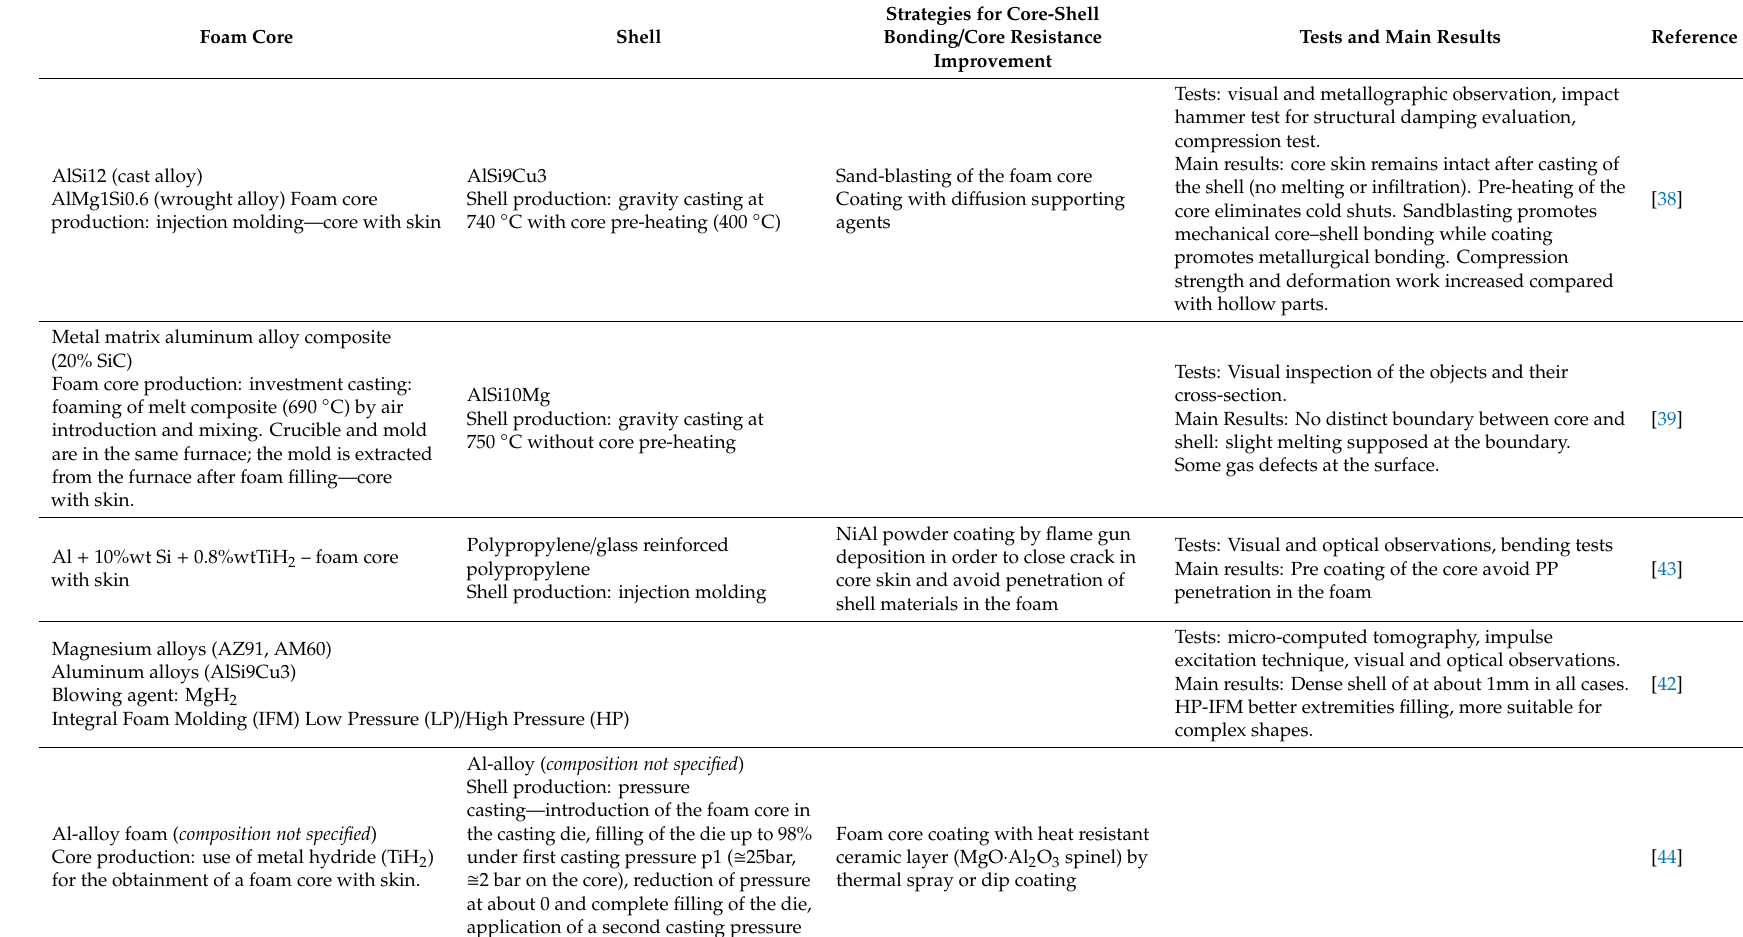
Table 2. Summary of literature and patent works on aluminum foams in casting